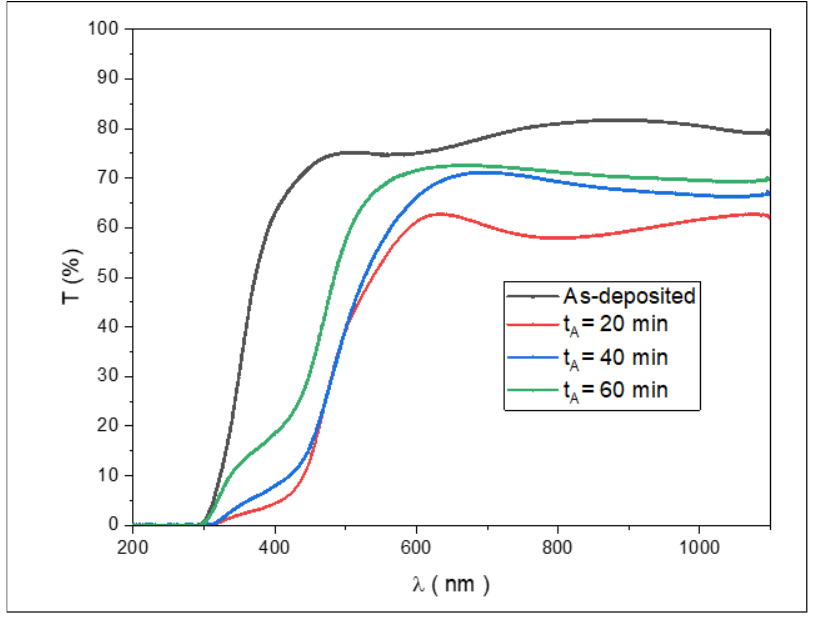
Figure 10. Transmittance spectra of as-deposited and annealed thin films at different